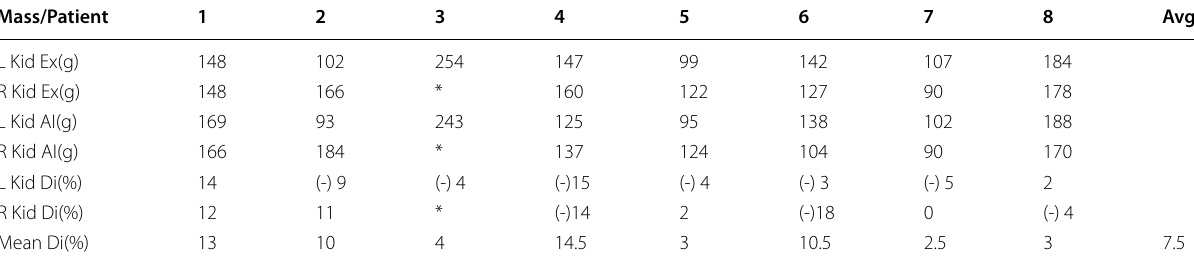
Table 3 Calculated left and right kidney masses (g) based on AI (labelled with “AI”) and experts (labelled with “Ex”) segmentation on dataset 4